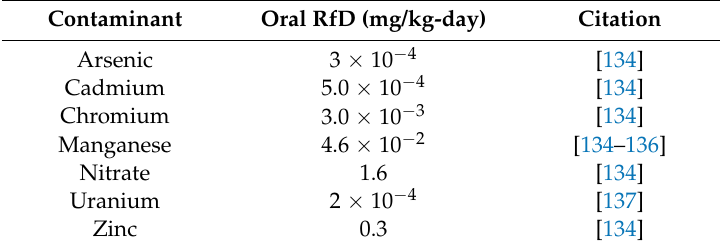
Table 2. Oral references doses and respective citation(s) for each